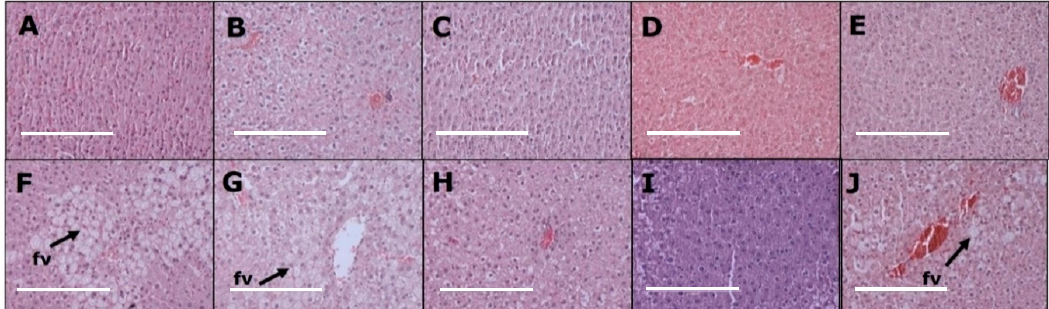
Figure 3. Effects of curcumin on fat deposition (“fv”) in the liver using haematoxylin and eosin stain in corn starch diet-fed rats (A), corn starch diet-fed rats given 5 mg/kg/day curcumin (B), corn starch diet-fed rats given 100 mg/kg/day curcumin (C), corn starch diet-fed rats given 5 mg/kg/day curcumin nanoparticles (D), corn starch diet-fed rats given blank nanoparticles (E), high-carbohydrate, high-fat diet-fed rats (F), high-carbohydrate, high-fat diet-fed rats given 5 mg/kg/day curcumin (G), high- carbohydrate, high-fat diet-fed rats given 100 mg/kg/day curcumin (H), high-carbohydrate, high-fat diet-fed rats given 5 mg/kg/day curcumin nanoparticles (I) and high-carbohydrate, high-fat diet-fed rats given blank nanoparticles (J). The white bar is 200 μ m.